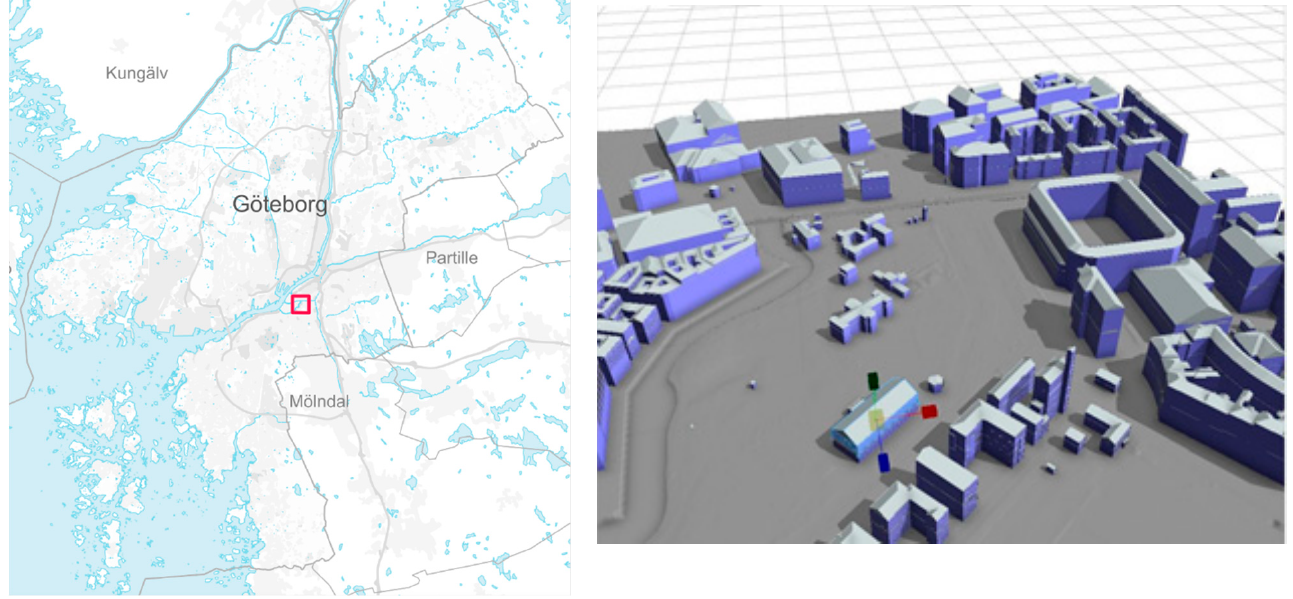
Figure 6. The test area in Gothenburg where the 3CIM test data were created ( left ) and data visualised in CityEngine to the ( right ). © Göteborgs stadsbyggnadskontor, Göteborgs stad.